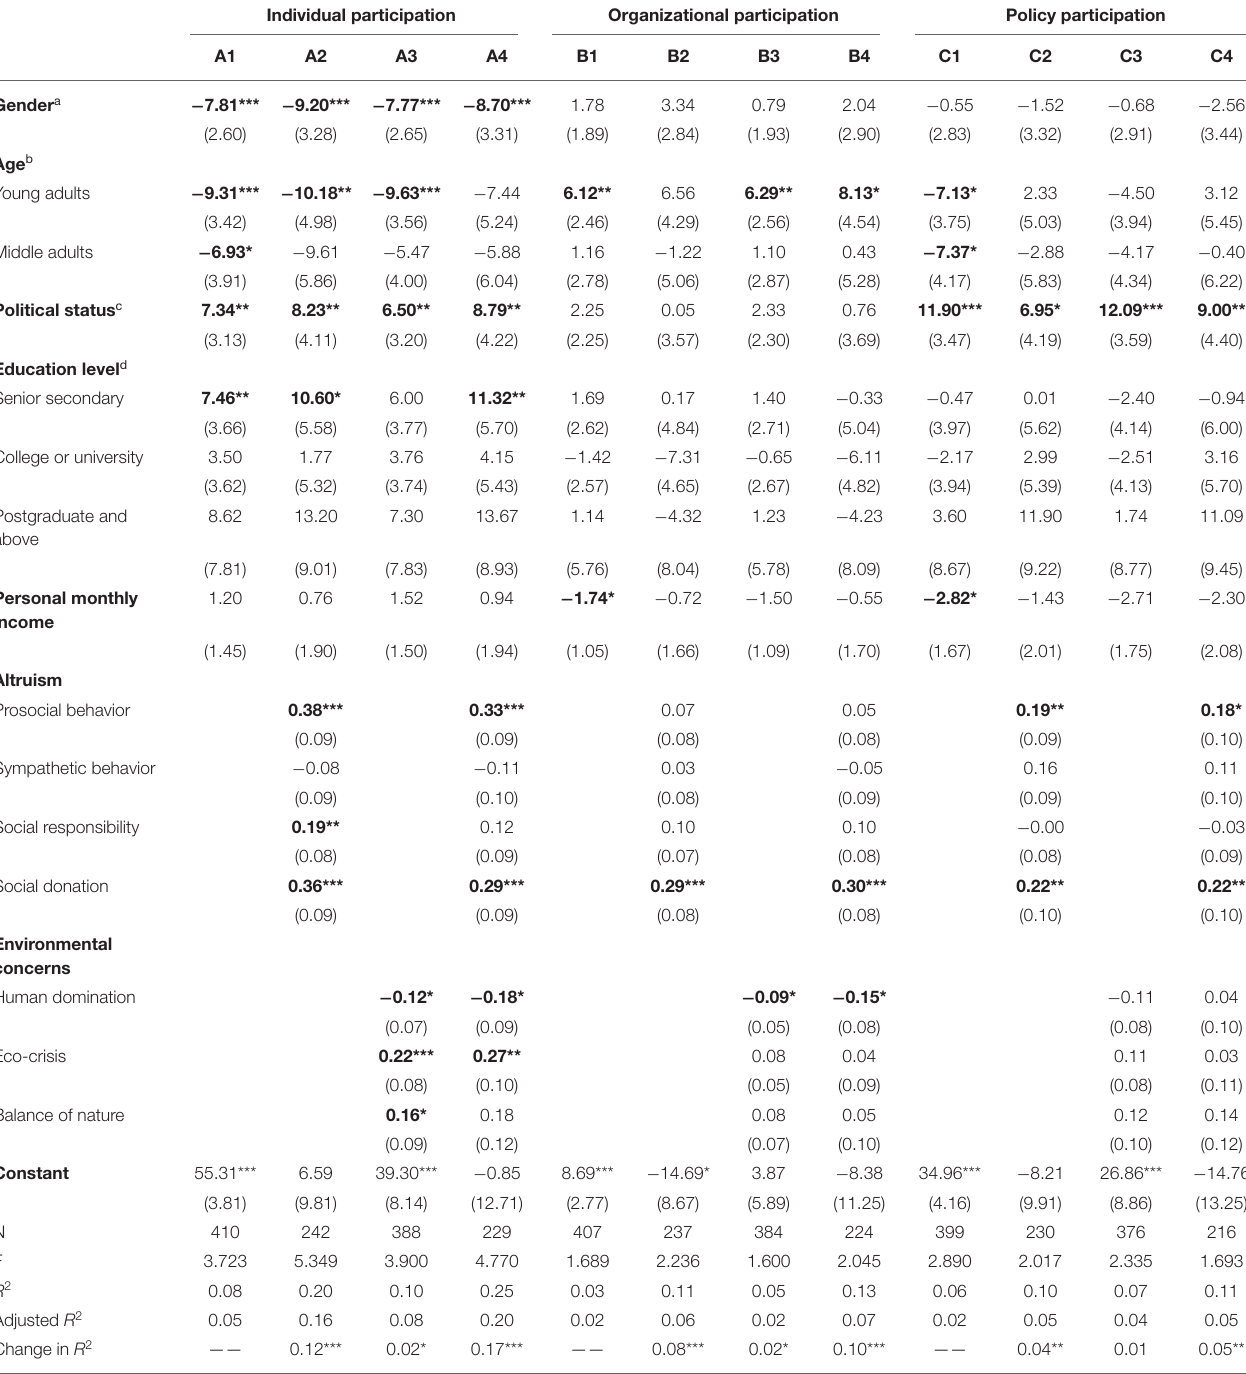
TABLE 5 | Environmental concern, altruism, and environmental